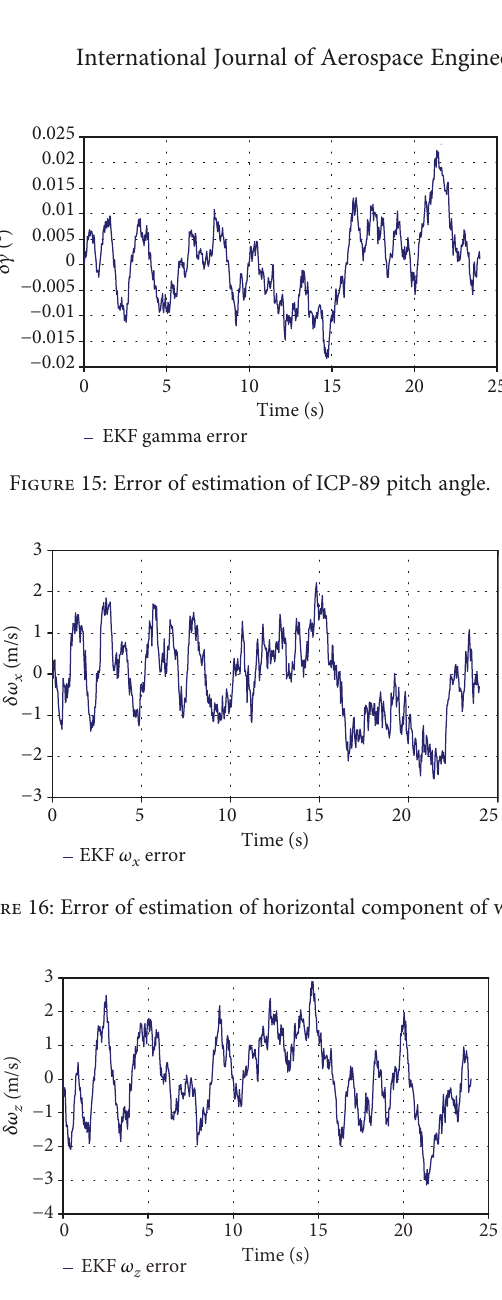
Figure 17: Error of estimation of vertical component of wind. Table 1: Comparison of OLS and EKF target localization